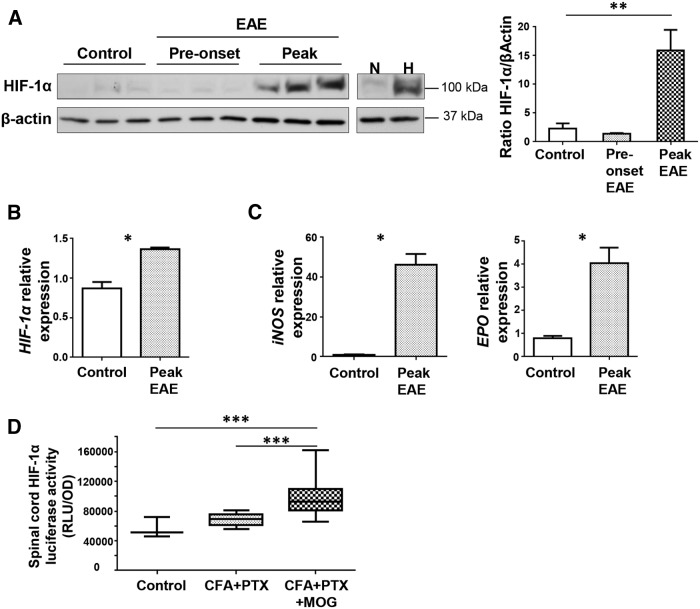
Stabilization and transcriptional activation of HIF-1α in the spinal cord of EAE mice. A, Western blot for HIF-1α in spinal cords of control (n = 3), pre-onset EAE, day 7 postimmunization (p.i.; n = 3) and peak EAE, day 16 p.i. (n = 3) mice. Normoxic (21% O2) and hypoxic (10% O2) brain extracts were loaded with spinal cord extracts of EAE mice to demonstrate HIF-1α protein stabilization. β-Actin-loading controls were performed on the same membrane. N, Normoxia; H, hypoxia. ANOVA: p = 0.002a. Peak EAE had a higher ratio of HIF-1α/β-actin than control (p = 0.006a) or pre-onset EAE mice (p = 0.003a). B, Quantitative real-time PCR analysis of HIF-1α expression in spinal cords of control (n = 3) and peak EAE (n = 3) mice, p = 0.01b. C, Quantitative real-time PCR analysis of HIF-1α target genes iNOS and EPO in spinal cords of control (n = 3) and peak EAE (n = 3) mice, p = 0.03c and p = 0.04d. D, Quantitative analysis of photon emission in spinal cord of HIF-1αluc control (n = 3) and peak EAE mice with MOG/CFA/PTX (n = 12) or CFA/PTX (n = 15). ANOVA: p = 0.00004e. MOG/CFA/PTX had greater bioluminescence than both CFA/PTX (p = 0.0005e) and control mice (p = 0.0005e). HIF-1αluc mice were killed and spinal cord tissues were excised to extract proteins. The bioluminescence signal was quantified ex vivo by the luciferase assay and expressed as RLUs per OD of proteins at 600 nm. Data are presented as mean ± SEM; *p < 0.05, **p < 0.01, ***p < 0.001 by Holm’s test in B and C, and one-way ANOVA followed by Tukey multiple comparisons in A and D
. Superscript letters refer to the statistical results in Tables 1, 2, and Results.